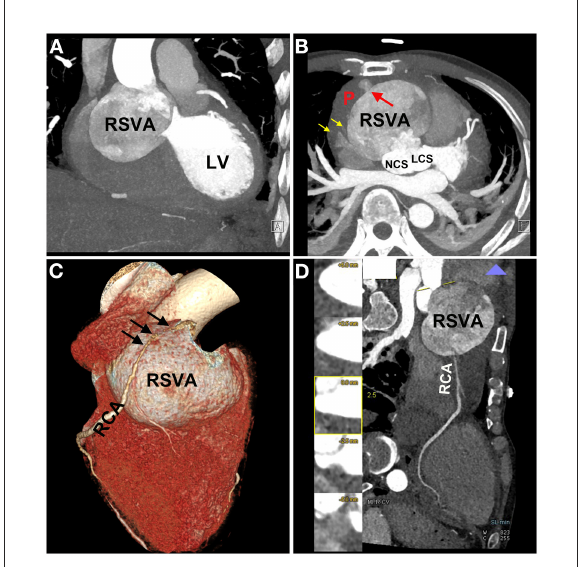
FIGURE3 Coronary computed tomography angiography (CTA) images. CTA images showing the RSVA (A) , which ruptured to the pericardium [red arrow (B) ], and some contrast medium leakage into the pericardial sac [yellow arrows (B) ]; the severely compressed RCA is stretched across the aneurysmal surface [black arrows (C) ]; the proximal segment of RCA was relatively slender (D) . RSVA, right sinus of Valsalva aneurysm; LV, left ventricle; NCS, noncoronary sinus; LCS, left coronary sinus; RCA, right coronary